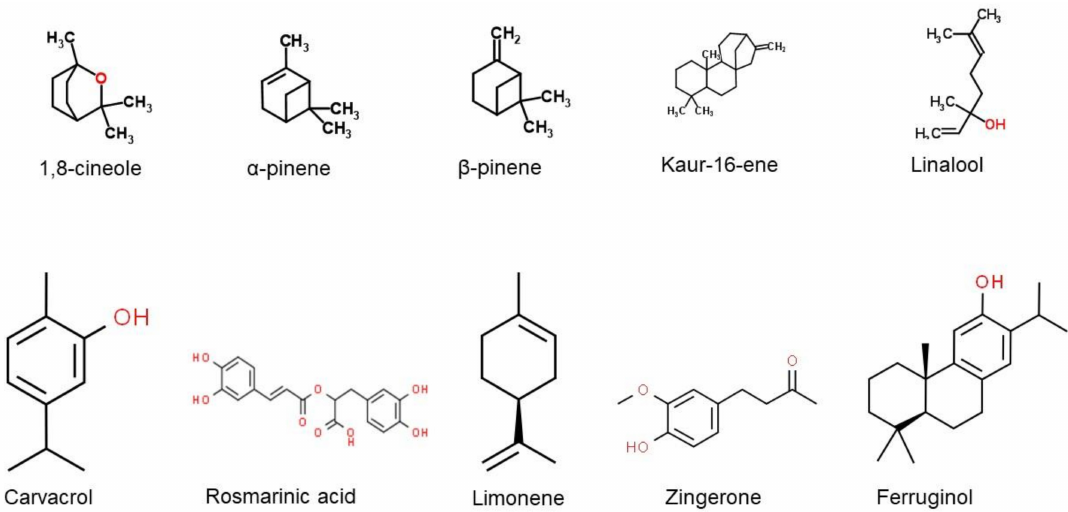
Figure 3. Chemical structures of the major EO components that have been reported to have anti-neurodegenerative properties. (obtained from